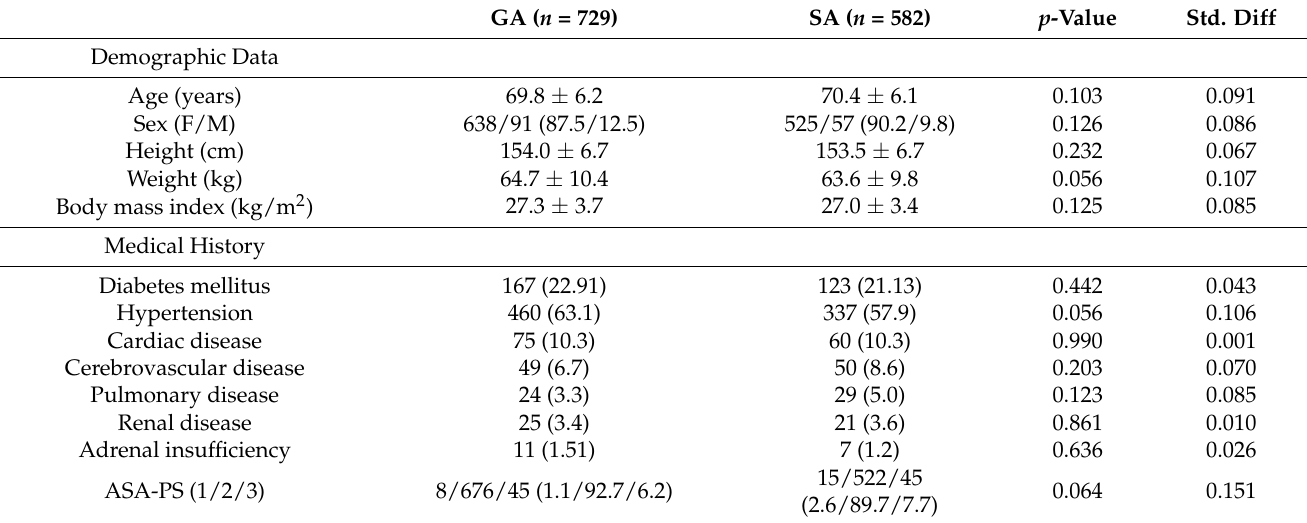
Table 1. Demographic and preoperative data in total